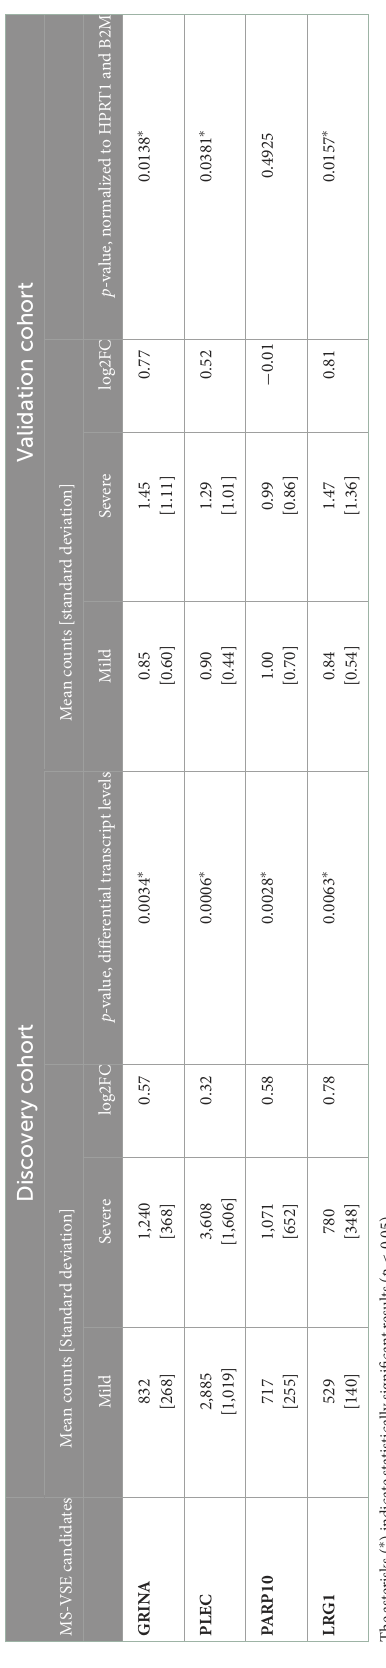
events, and/or longitudinally, would be needed to better support any potential cause-and-effect